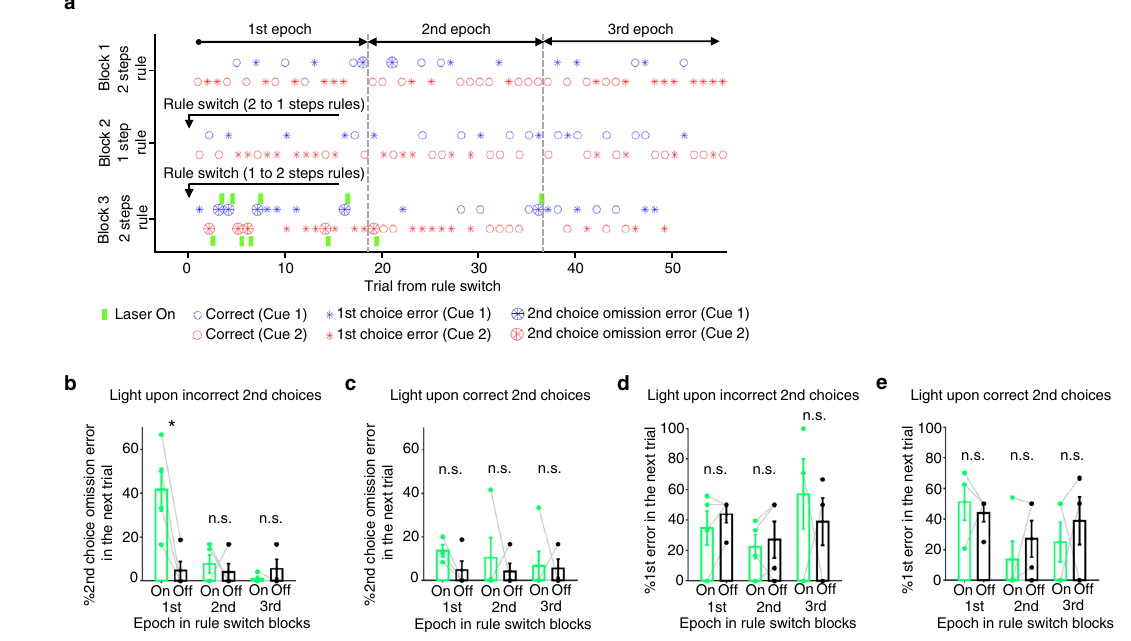
Fig. 9 | Optogenetic silencing of ACC neurons upon incorrect 2nd choices induced sequential choice errors in the immediately subsequent trials that followed rule switches. a Task performance chart of a representative session in which light was delivered upon incorrect 2nd choices in Rule Switch-block. Green bar, light delivery. Small circle, correct trial. Asterisk, 1st choice error. Large circle fi lled with an asterisk, 2nd choice omission error. Blue and red represent two dis- tinct tone cues. Gray dotted lines show borders separating three epochs in each block (1 – 18th, 19 – 36th, and 37 – 55 trials for 1st, 2nd and 3rd epochs, respectively). b 2nd choice performance was plotted for trials that immediately followed a 2nd choice omission error trial.On and Off represent trials in whichlight wasdelivered and not delivered,respectively.The performancewasplotted for eachofthe three epochs separately. * P =0.0201 for 1st epoch, P =0.575 and 0.391 for 2nd and 3rd epochs, respectively (two-sided two samples t -test, n =4 rats). Error bar, SEM.